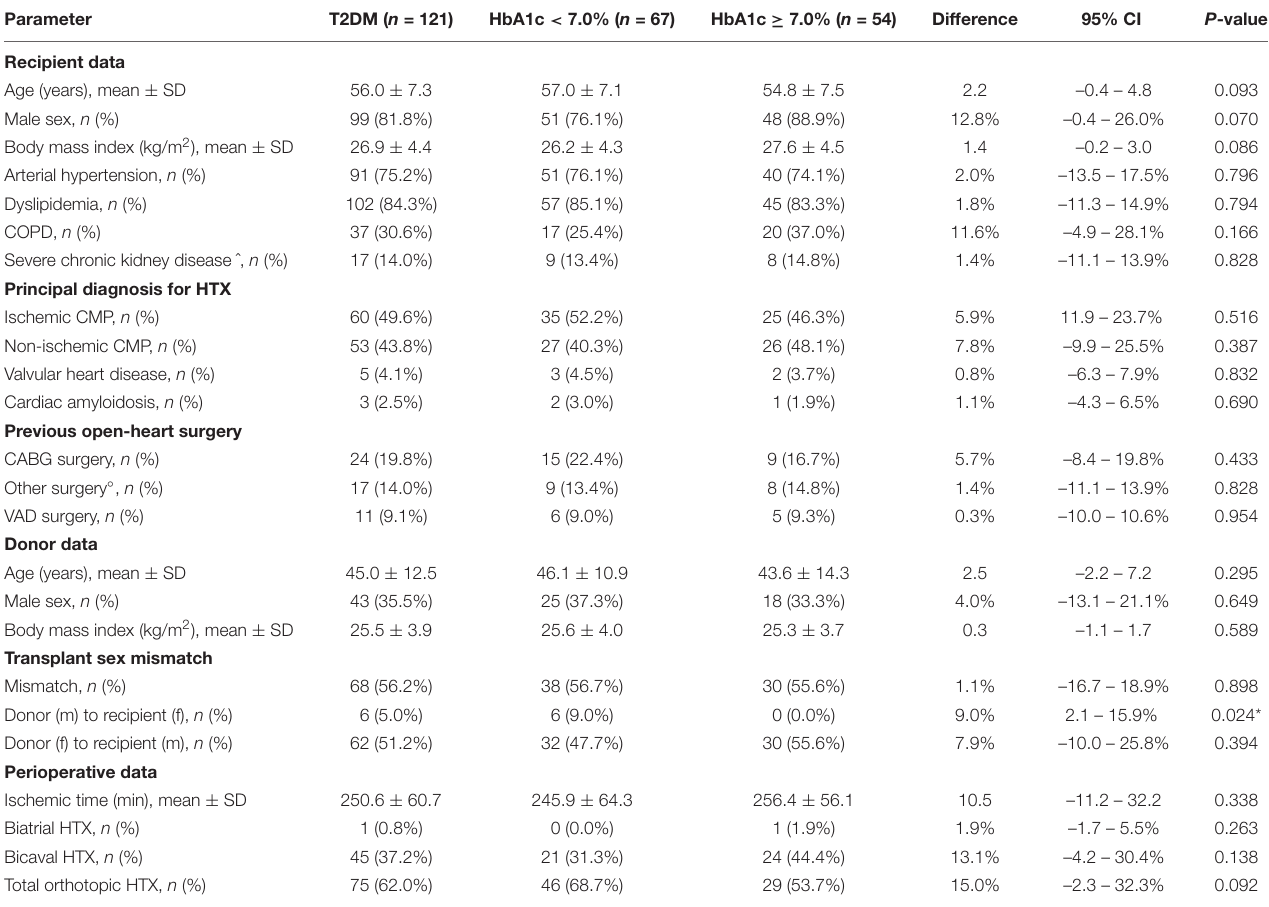
TABLE 2 | Baseline characteristics – stratified by HbA1c at HTX.